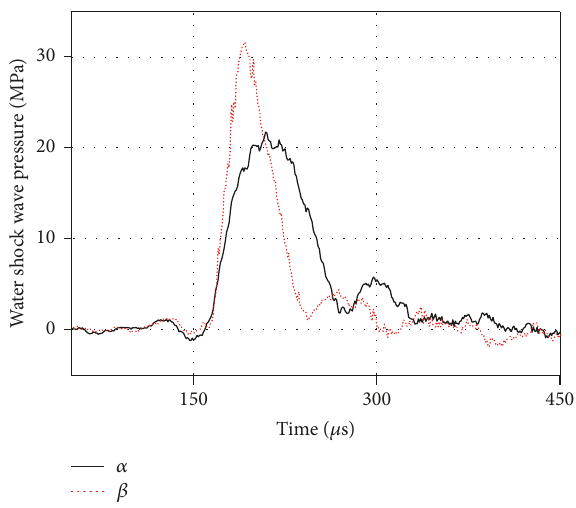
Figure 1: Pressure waveforms of WSWs in 𝛼 and 𝛽